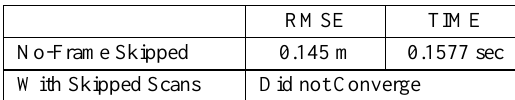
Table 6. Second Experiment ICP Results